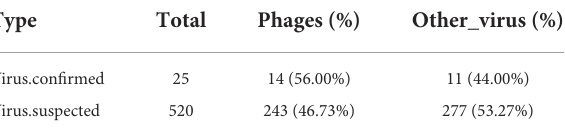
TABLE 5 Statistical analysis of viral types in the confirmed and suspected virus.